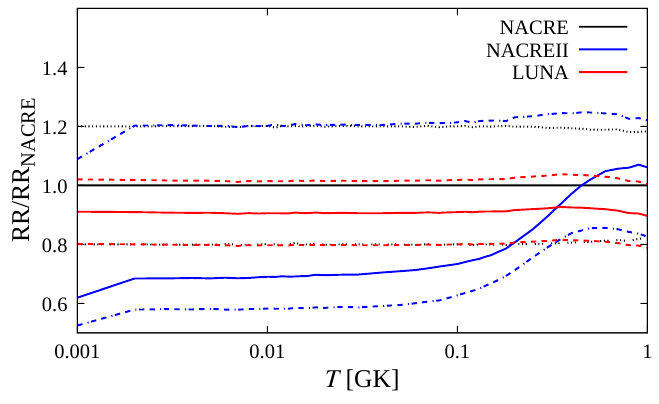
Figure 4. Reaction rate for the 6 Li( p , γ ) 7 Be reaction, normalized to the NACRE rate [24]. The NACRE II rate [16] is also shown for comparison. Dashed lines represent the uncertainty on the NACRE rate (black), on NACREII rate (blue) and on LUNA rate